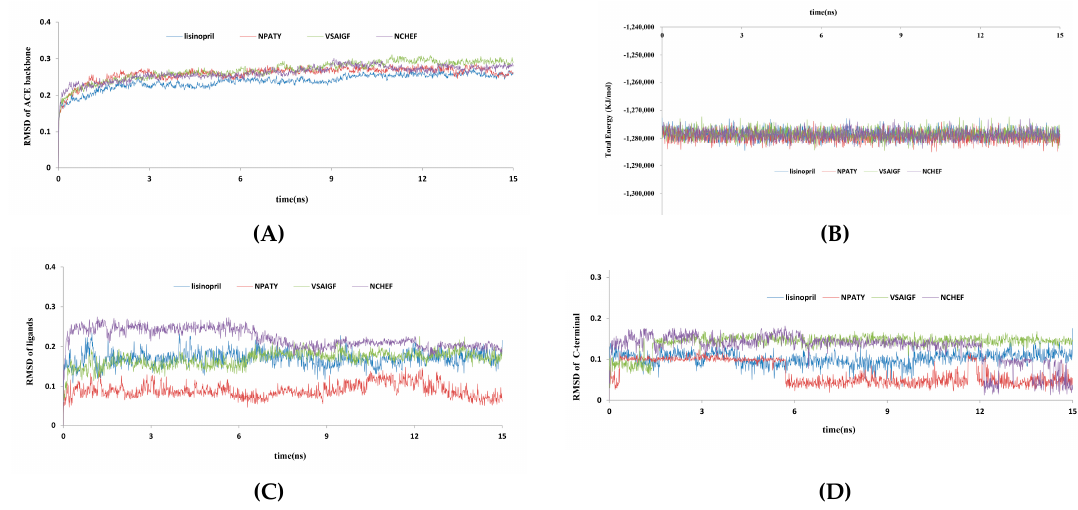
Figure 7. Trajectory of the MD simulation for four complexes: ( A ) average protein backbone RMSD; ( B ) total Energy; ( C ) RMSD of ligands; and ( D ) RMSD of first active amino acids in C ‐ terminal of ligands. Blue indicates lisinopril–1O86; red indicates NPATY–1O86; green indicates VSAIGF–1O86; and purple indicates NCHEF–1O86.